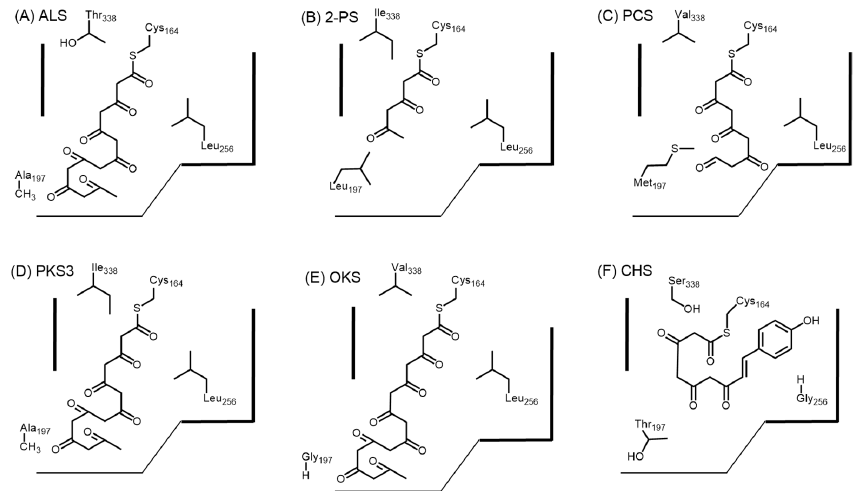
Figure 5. Schematic representation of the active sites of ( A ) R. Palmatum ALS; ( B ) G. hybrida 2-PS; ( C ) A. arborescens PCS; ( D ) A. arborescens PKS3; ( E ) A. arborescens OKS; and ( F ) M. sativa CHS. The residue